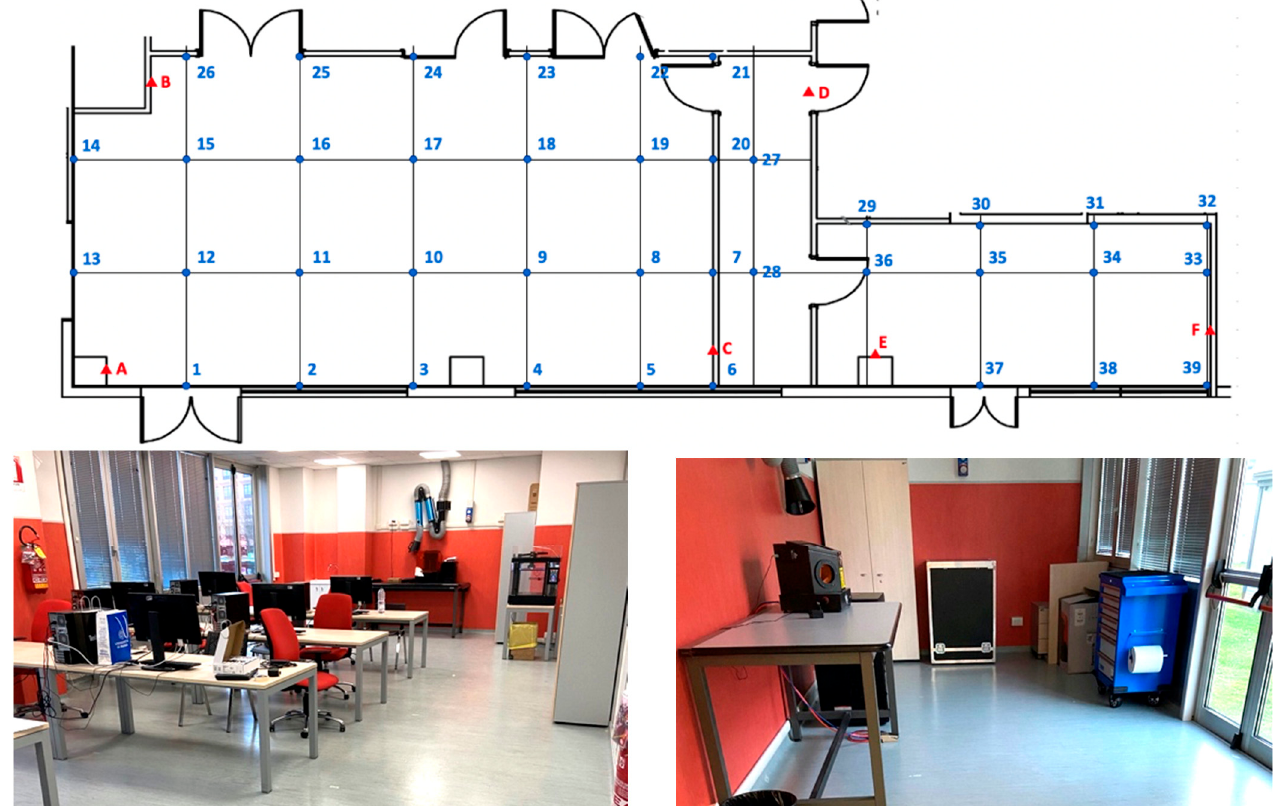
Figure 4. Map of the area ( above ) and two pictures of the laboratory, the main room ( bottom left ) and the secondary room ( bottom right ).